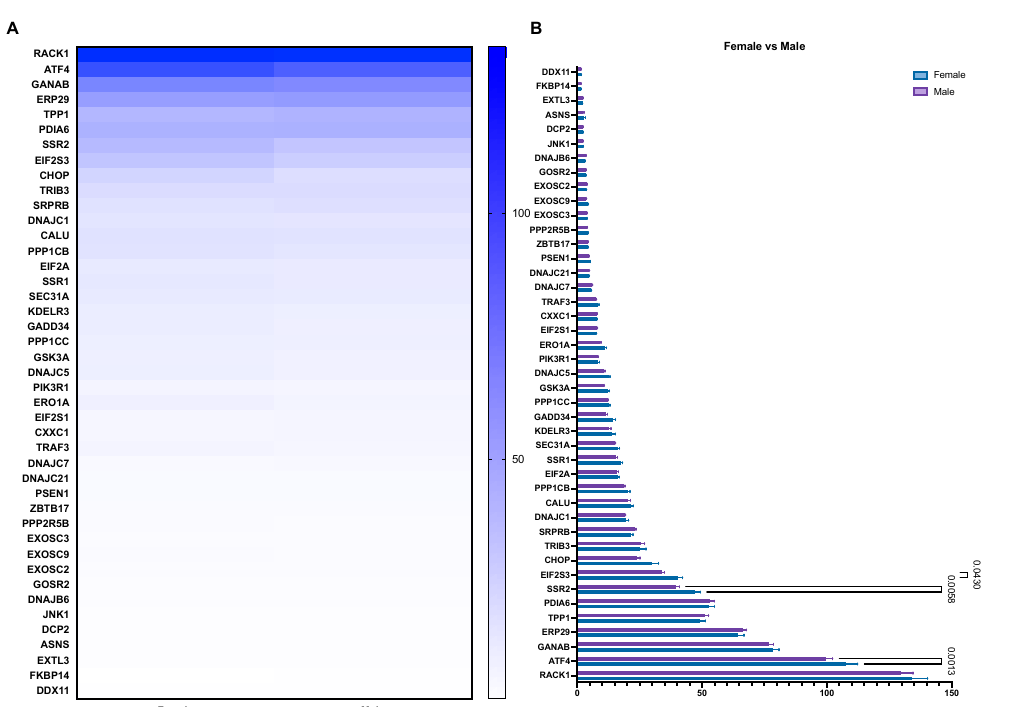
Biology 2021 , 10 , x FOR PEER REVIEW Figure 6. The mRNA expression of unfavorable UPR-associated markers per sex shown in a heatmap ( A ) and a bar chart ( B ).